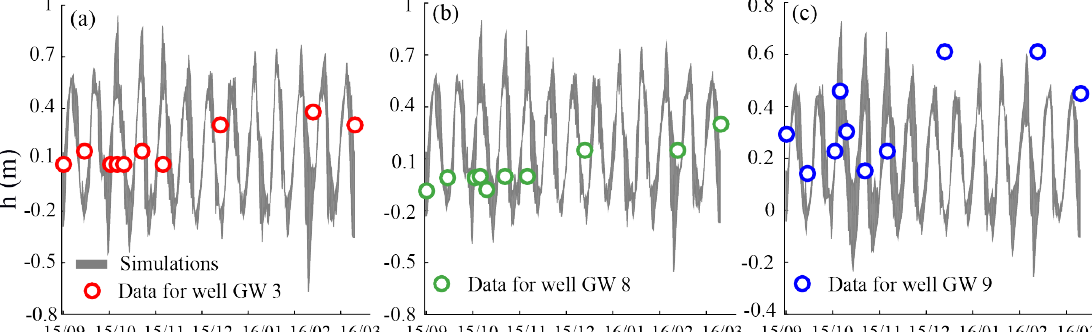
Figure 9. Validation of the groundwater model through stochastic simulations of the water table at three observation wells in Hoboken: ( a ) GW 3; ( b ) GW 8; and ( c ) GW